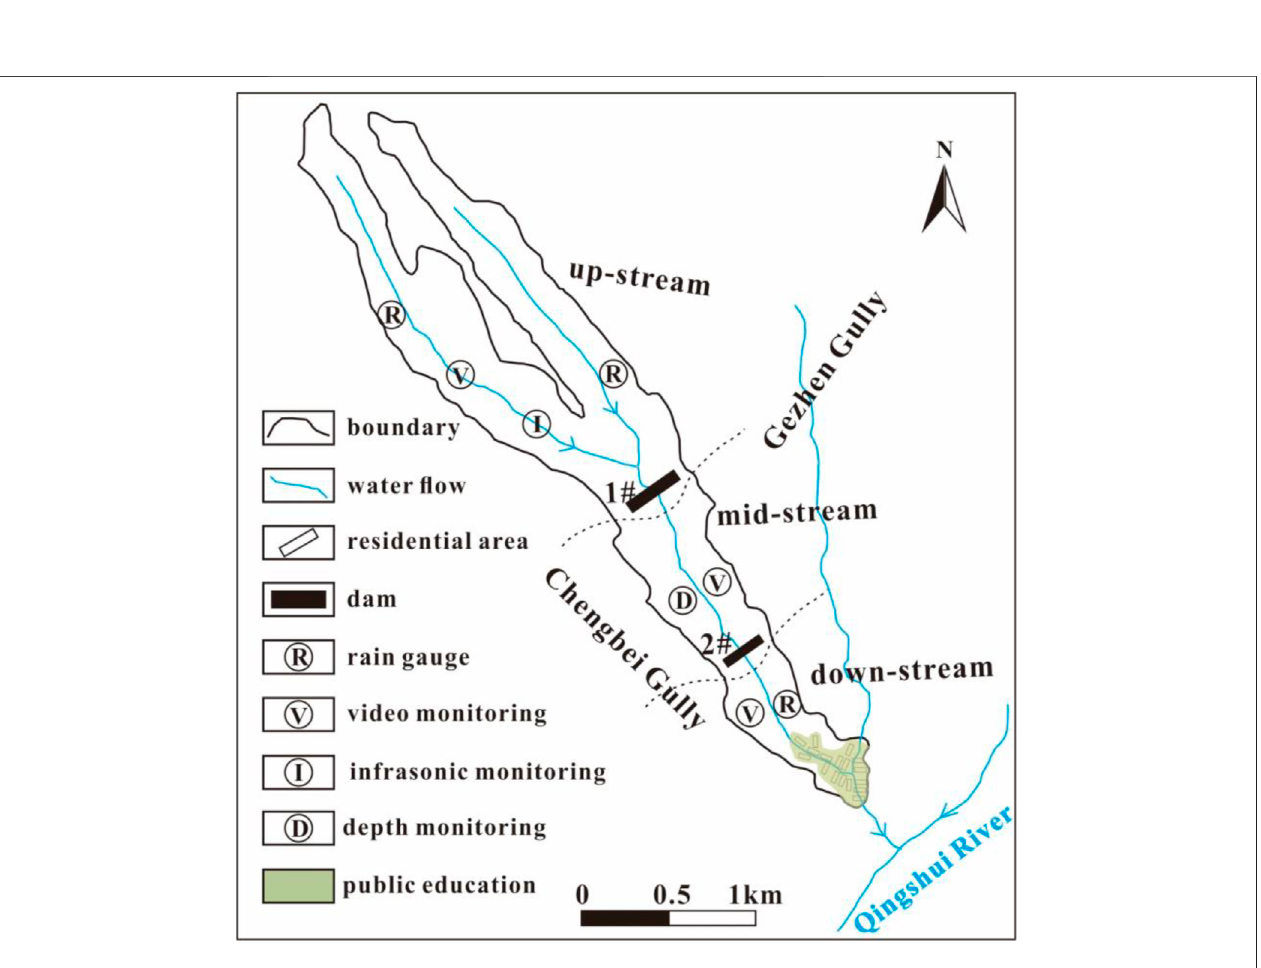
Frontiers in Earth Science |